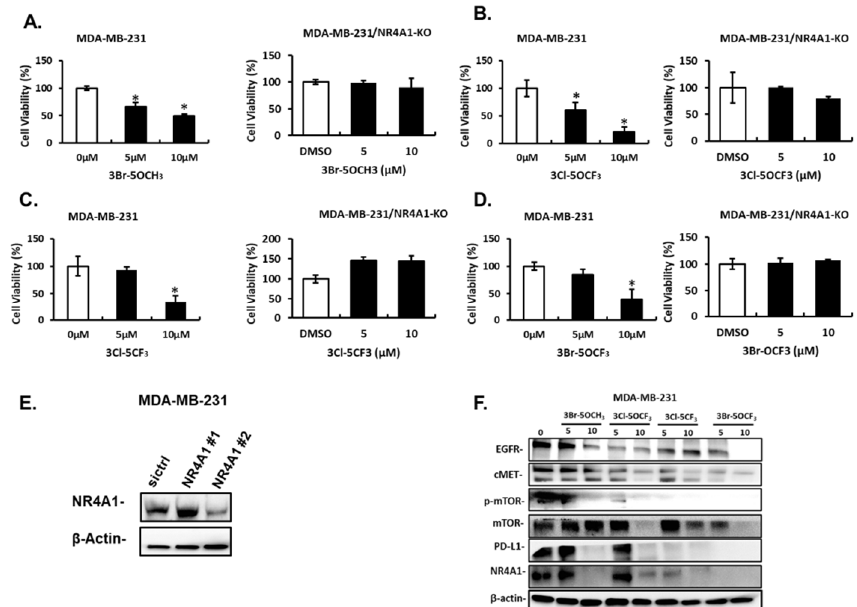
Figure 3 . Effects of 3,5-disubstituted phenyl CDIM analogs on MDA-MB-231 cell viability and NR4A1-regulated gene products. MDA-MB-231 cells were treated with 3-Br-5-OCH 3 ( A ), 3-Cl-5- OCF 3 ( B ), 3-Cl-5- CF 3 ( C ), and 3-Br-5- OCF 3 ( D ) for 24 h and effects on cell proliferation were determined in cells expressing NR4A1 and after NR4A1 knockdown, as outlined in the Materials and Methods section ( E ), The uncropped Western blots have been shown in Figure S1. Cells were transfected with oligonucleotides targeting NR4A1 and after 72 h whole cell lysate were analyzed by western blots ( F ). (NR4A1 #2 used above) Cell lysates from MDA-MB-231 cells were treated with the CDIM compounds and analyzed by western blots to determine effects on NR4A1-regulated gene products. Results ( A – D ) are given as means ± SD for at least three replicate determinations for each treatment group, and significant ( p < 0.05) inhibition is indicated (*).